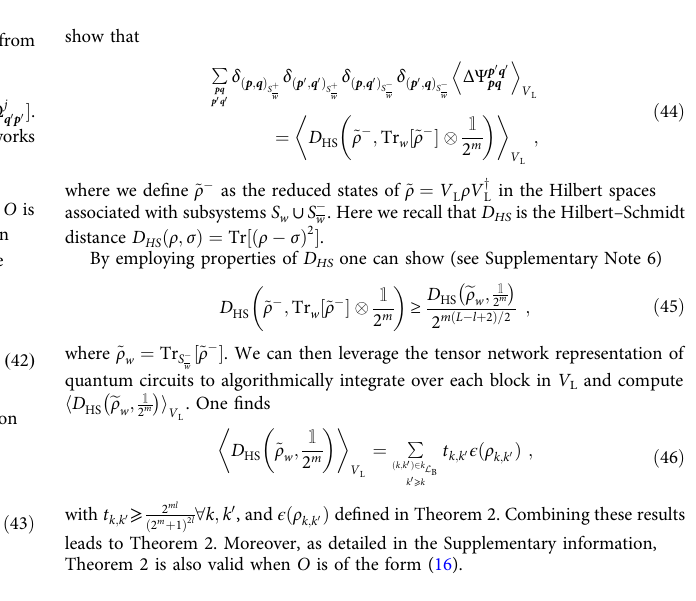
Fig. 8 Tensor-network representations of the terms relevant to Var[ ∂ ν C ]. a Representation of Ω i qp of Eq. (34) (left), where the superscript indicates that O is replaced by O i . In this illustration, we show the case of n = 2 m qubits, and we denote P (middle) and of Tr ½ Ω i qp (cid:3) Tr ½ Ω j q 0 p 0 (cid:3) (right). b By means of the Weingarten calculus we can algorithmically integrate over each block in the ansatz. After each integration one obtains four new tensors according to Eq. (38). Here we show the tensor obtained after the integrations d μ ð W Þ Tr ½ Ω i Ω j q 0 p 0 (cid:3) , which are needed to compute h qp (cid:3) Tr ½ sum of the form (49), where the deltas over p , q , p 0 , and q 0 arise from the contractions between P pq and P p 0 q 0